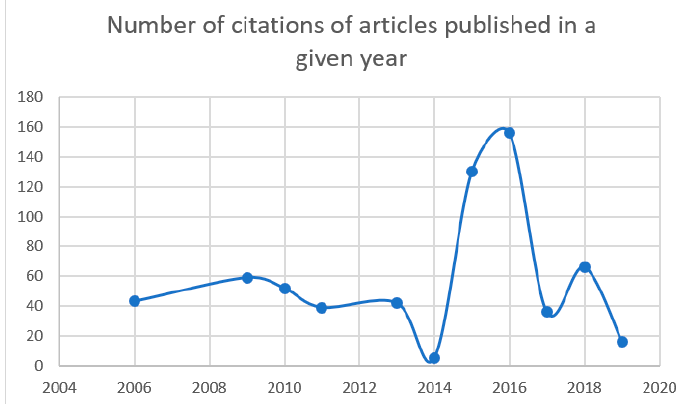
Figure 2. Number of citations of the studied literature collection (source: own study).